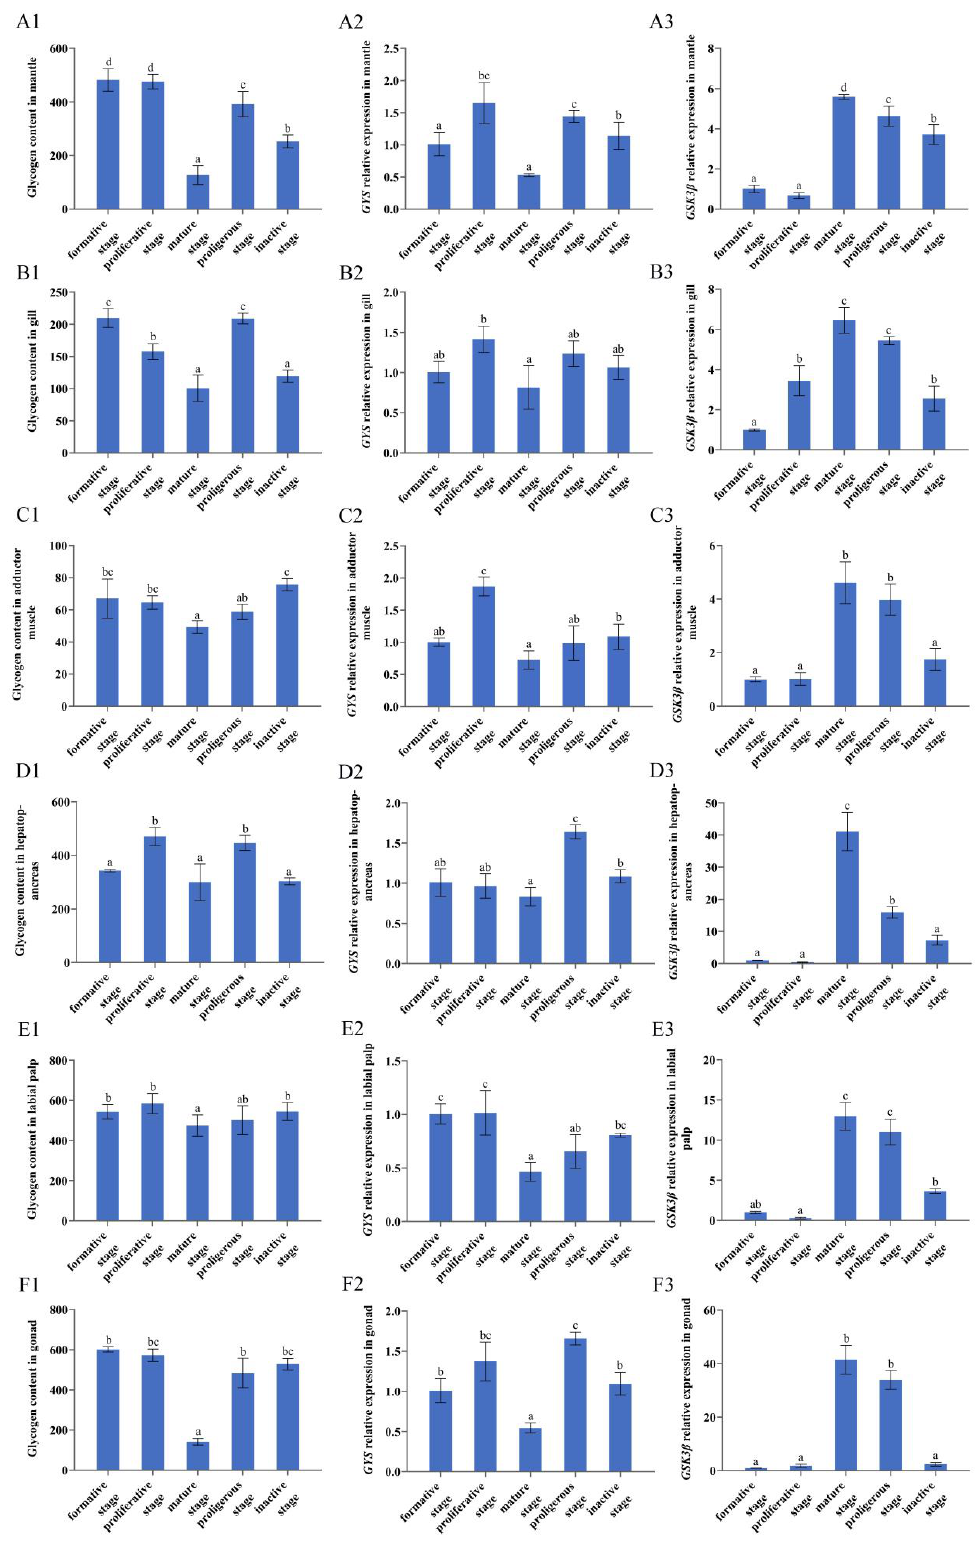
Figure 5. Glycogen content (mg/g dry mass), GYS relative expression levels, and GSK3 β relative expression levels in mantle ( A1 – A3 ), gill ( B1 – B3 ), adductor muscle ( C1 – C3 ), hepatopancreas ( D1 – D3 ), labial palp ( E1 – E3 ) and gonad ( F1 – F3 ) of C. ariakensis at five developmental stages. Bar values represent the mean of glycogen content, GYS relative expression, and GSK3 β relative expression in three oysters, each point replicated three times. Error bars represent standard error of